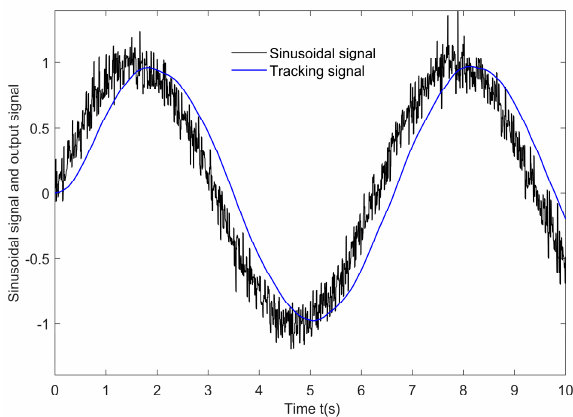
Figure 2. Comparison of input signal and output tracking signal. The approximate differential signal of the speediest tracking differentiator to the input signal is shown in Figure 3.